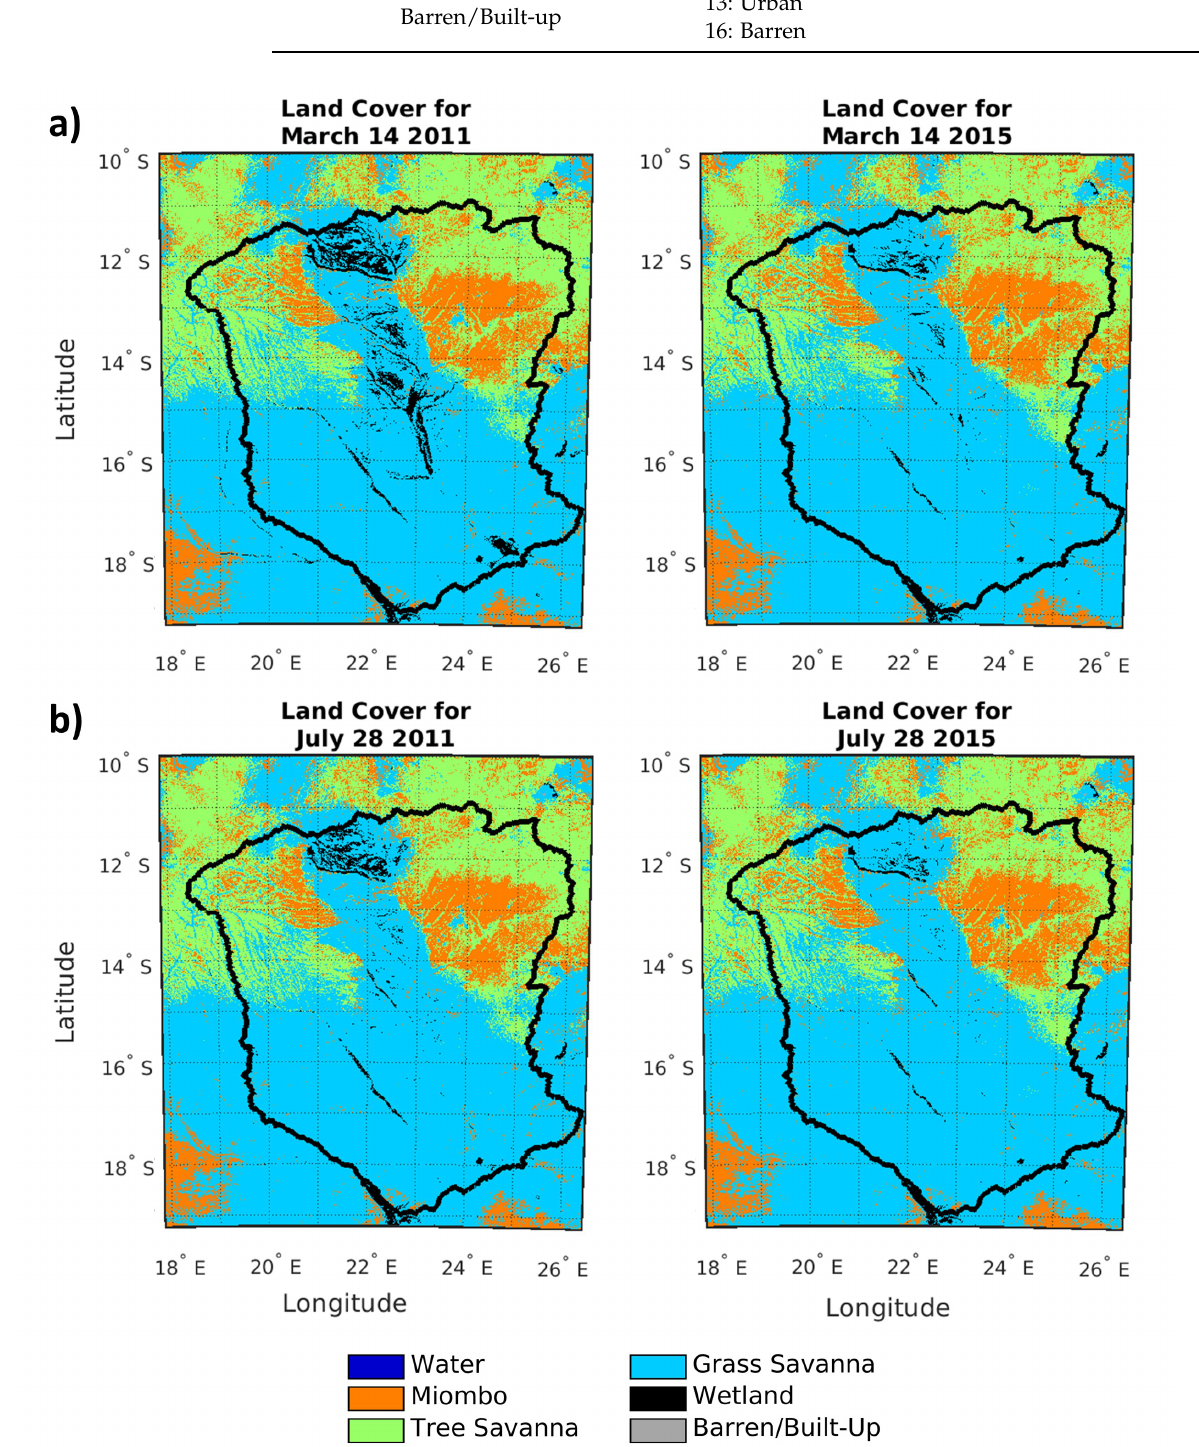
Figure 4. Seasonal land cover derived from MODIS MCD12Q1 land cover classes for a wet year (2011; left) and a dry year (2015; right) to compare ( a ) wetland extent after the peak of the rainy season to ( b ) wetland extent during the middle of the dry